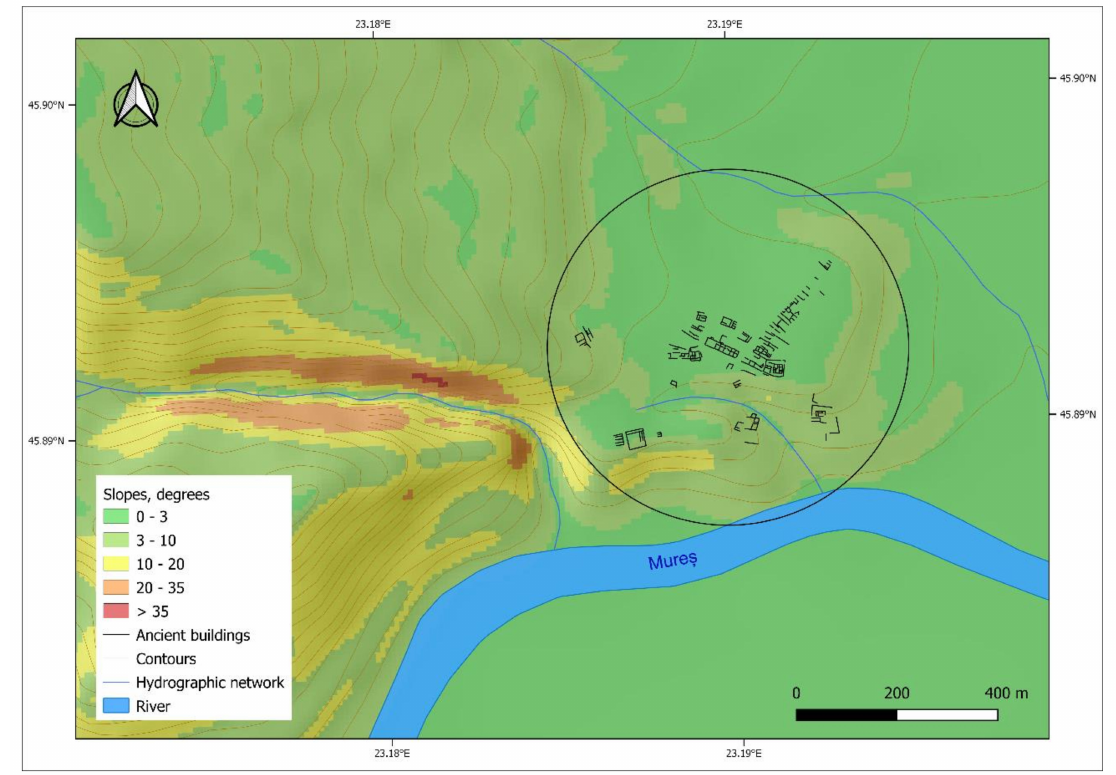
Figure 13. Germisara archaeological site – possible surface deterioration caused by the erosion